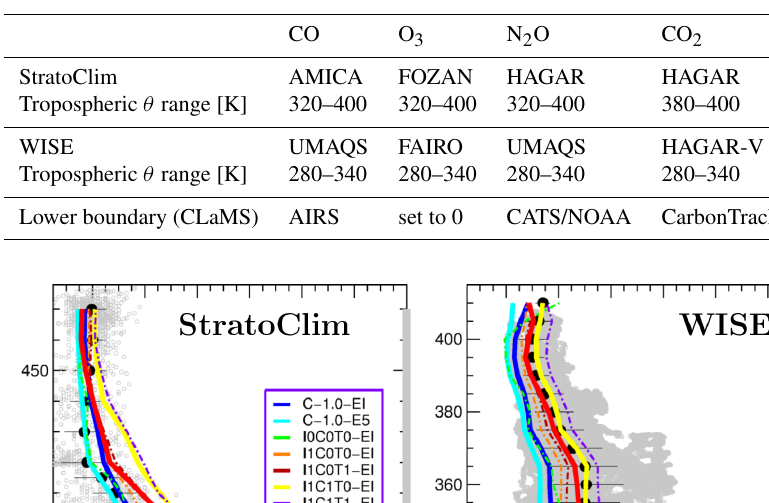
Table 3. Observed species, instruments, and θ ranges included into the validation procedure, and the origins of the data used for the lower boundary condition in CLaMS (AIRS – atmospheric infrared sounder on NASA’s Aqua satellite, Chromatograph for Atmospheric Trace Species (CATS) from NOAA, CarbonTracker from NOAA, version CT-NRT.v2017). For details of the CLaMS boundary conditions see Konopka et al. (2019) (CO 2 ) and Pommrich et al. (2014) (all other species). Tropospheric θ ranges define maximal vertical extensions where new transport modes in CLaMS 2.0 are evaluated in terms of the root mean square differences between observations and model results. The instruments and their performance during StratoClim are described in von Hobe et al. (2021) and during WISE in Krasauskas et al. (2021) and Lauther et al. (2022).